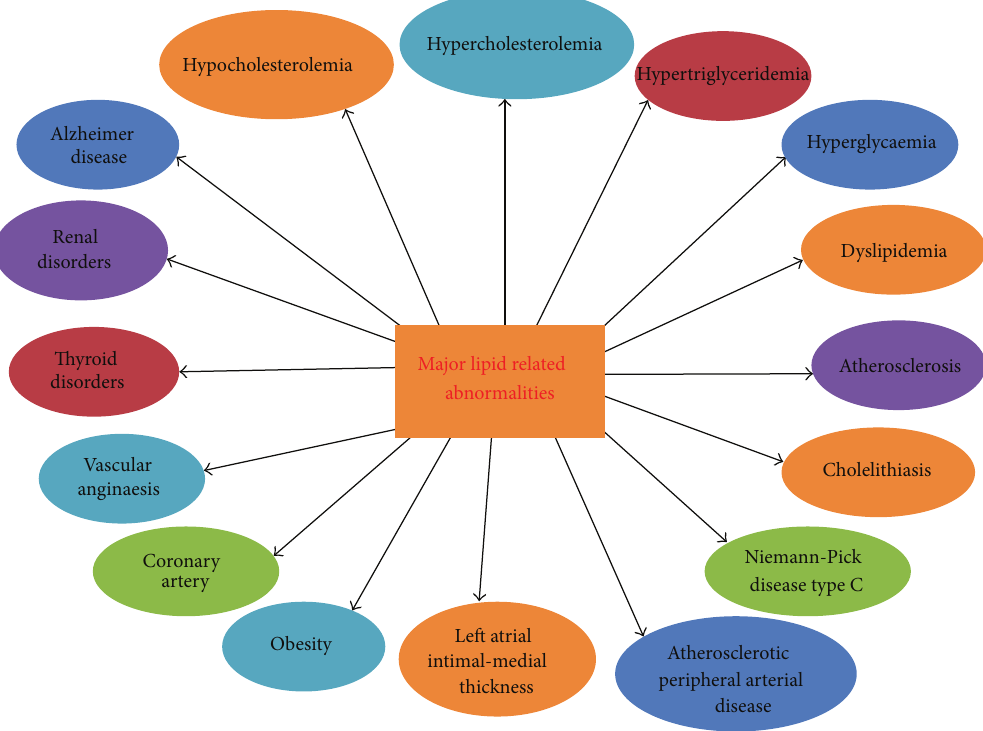
Figure 2: Showing major lipid abnormalities responsible for various cardiovascular disorders found in human.